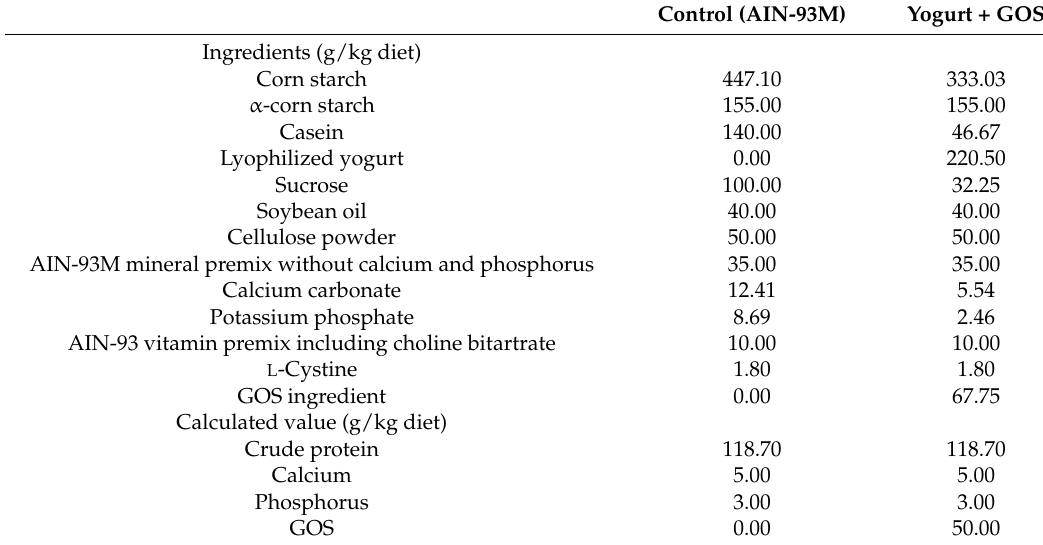
Table 1. Composition of the experimental